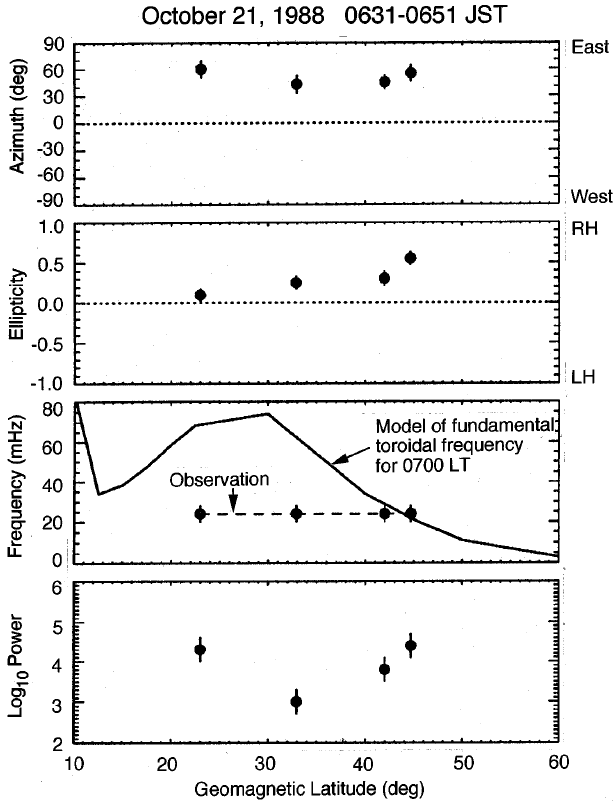
Fig. 6. Latitudinal profile of parameters characterizing a single- frequency Pc 3 pulsation observed on the ground (adapted from Fig. 11 of Feng et al ., 1995). The solid curve in the third panel indicates the frequency of fundamental-mode toroidal oscillation derived from a